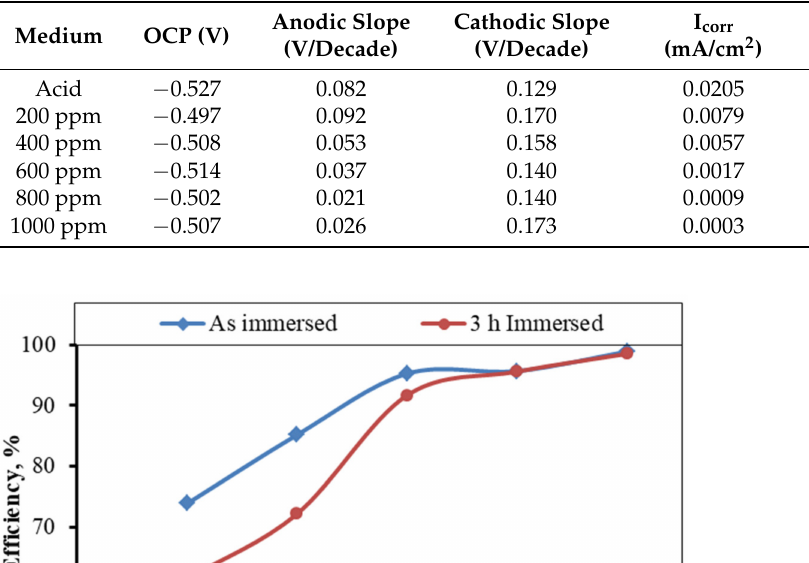
Figure 17. Potentiodynamic polarization curves for the mild steel in the 1 M H 2 SO 4 containing different concentrations of the inhibitor in immersed conditions. Table 5. The anodic slopes, cathodic slopes, and inhibition efficiencies for the 3-h-immersed samples.